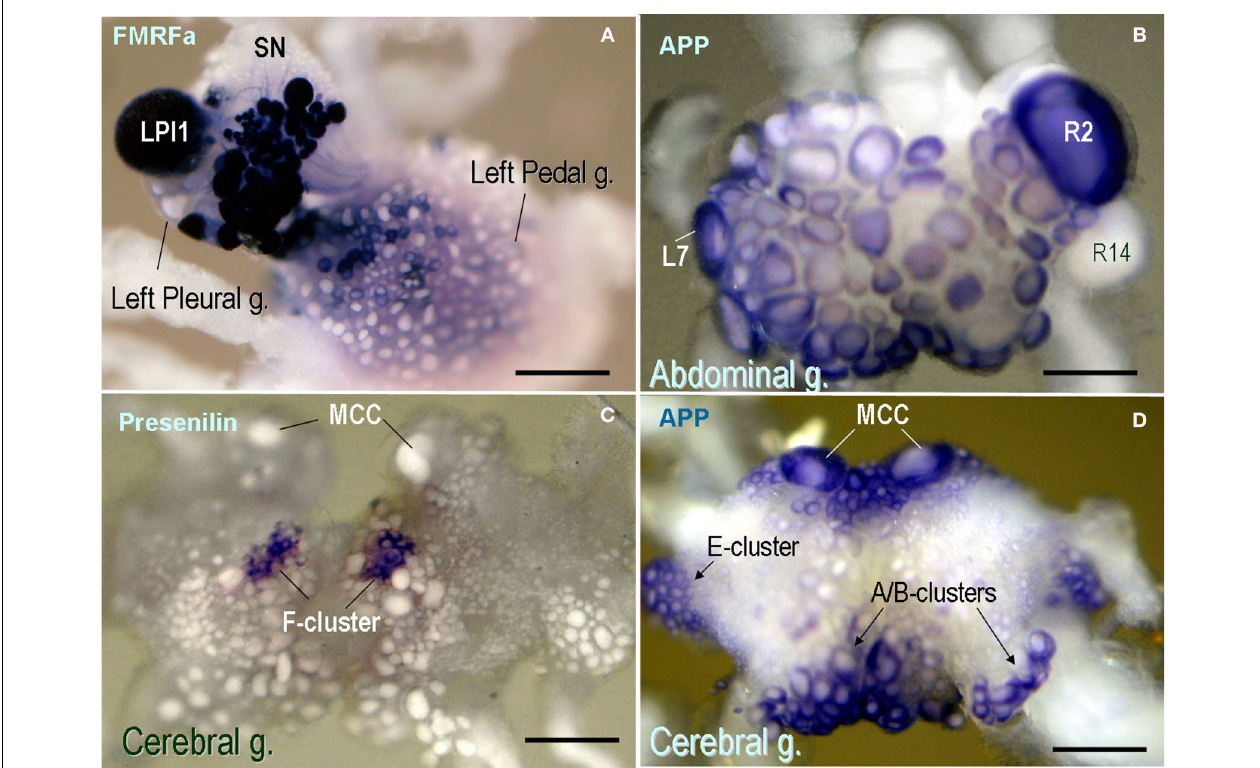
FIGURE 4 | Expression patterns of selected neuronal genes in the CNS of Aplysia californica ( in situ hybridization). (A) FMRFamide expression in the pleural-pedal ganglia (dark-blue cells); Giant LPl1 neurons (as well as R2 neurons – not shown) contain FMRFamide while pleural sensory neurons (SN) do not express this transcript. (B) The expression of the amyloid precursor protein (APP) mRNA in the abdominal ganglion (dorsal view). Note a prominent expression of APP in R2 and selected motoneurons including L7. The neurosecretory neuron R14 does not show any noticeable expression of this mRNA. (C) Aplysia presenilin is selectively